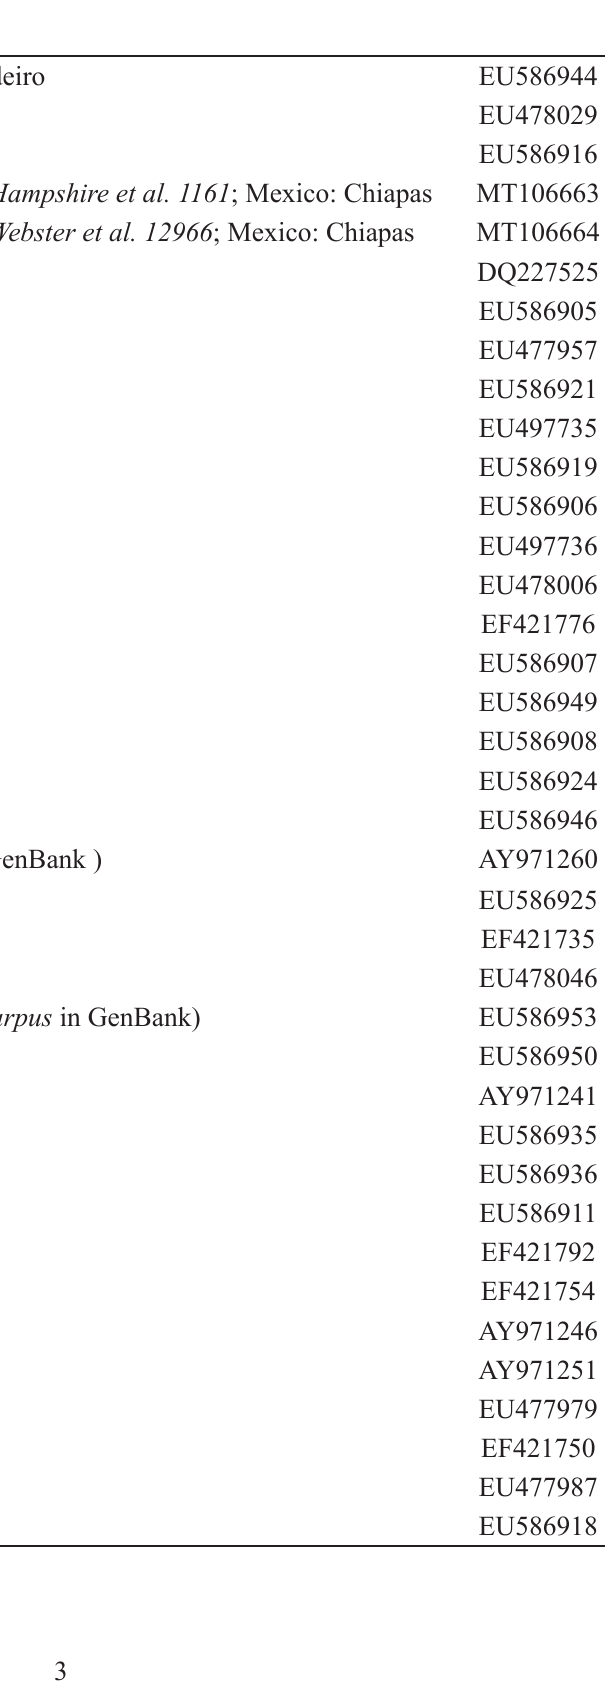
Table 1. List of GenBank accession numbers of the ITS sequences used to provide a phylogenetic context to the new species (shown in Fig.